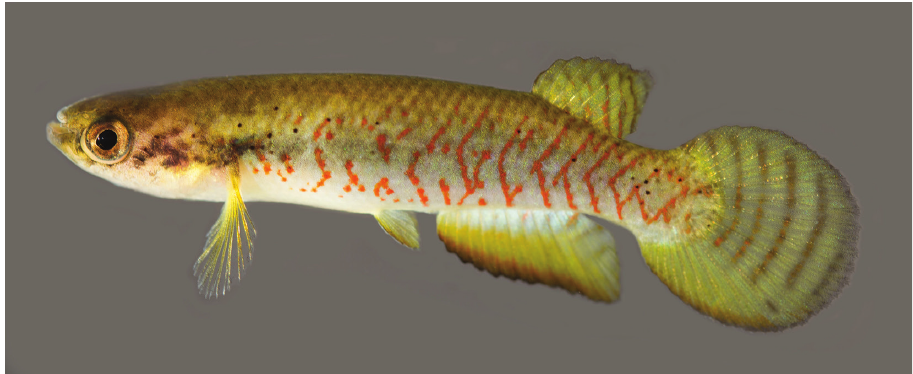
Figure 6. Melanorivulus regularis sp. n., holotype, UFRJ 6878, male, 26.9 mm SL. Photograph by W.J.E.M.